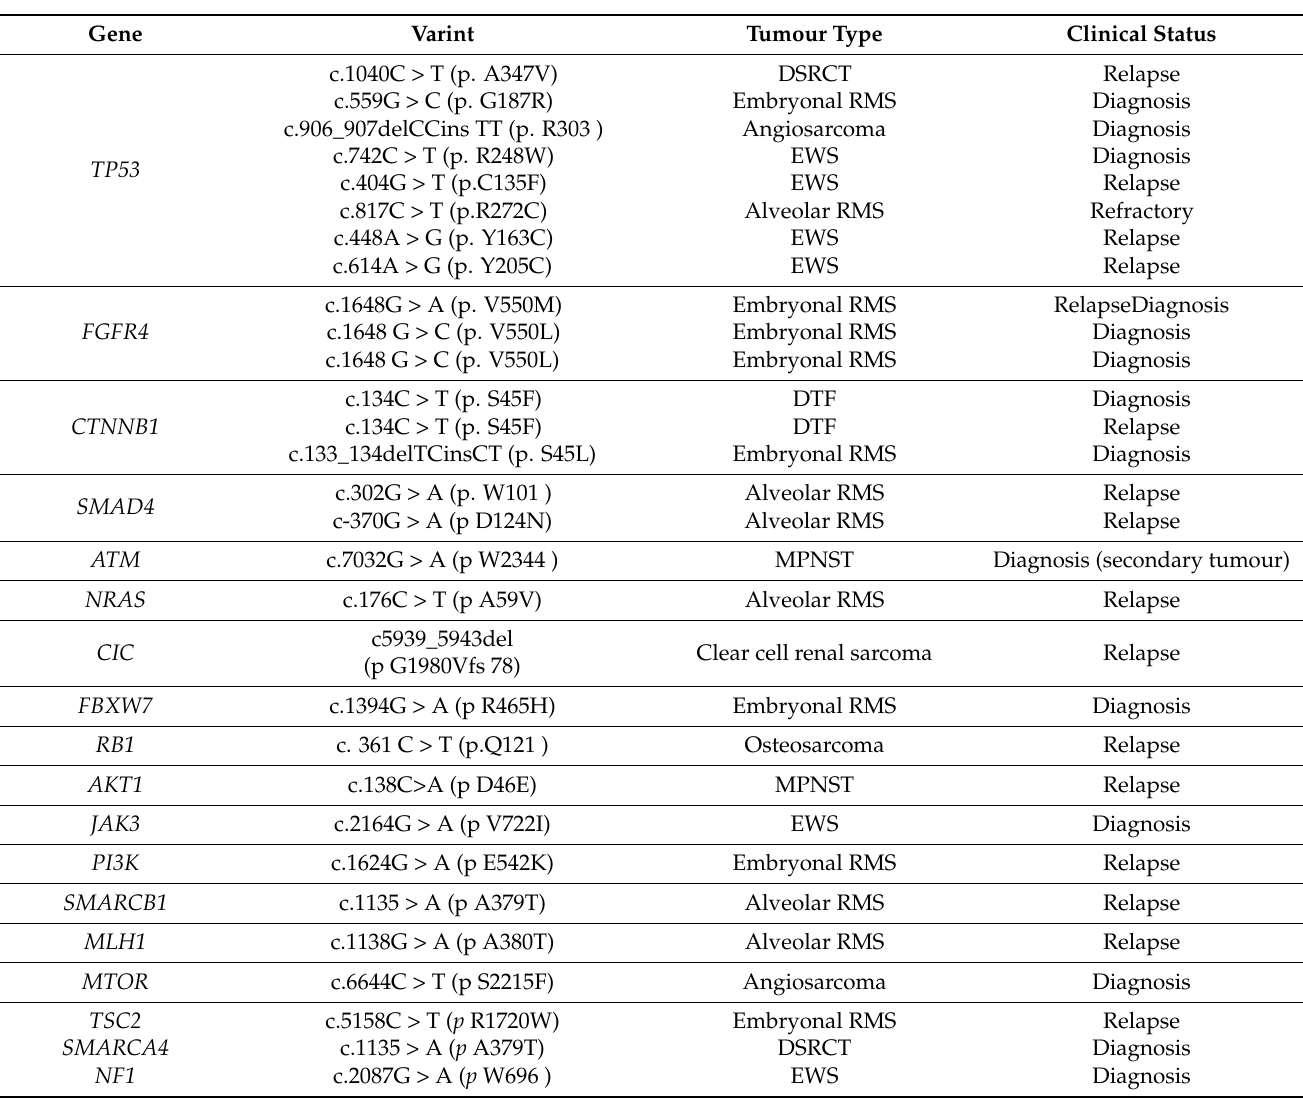
Table 2. Tumour sequencing results: Mutated gene, variant, sarcoma subtype and clinical status. DSRCT: desmoplastic small round cell tumour; RMS: rhabdomyosarcoma; EWS: Ewing sarcoma; DTF: desmoid-type fibromatosis; MPNST: malignant peripheral nerve sheath